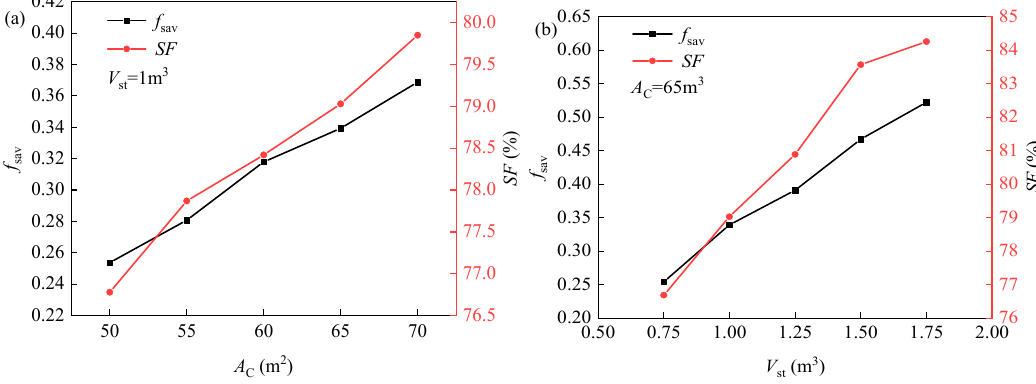
Figure 9. Variation of system SF and f sav with collector area and storage tank volume ( a ) collector area ( b ) storage tank volume.